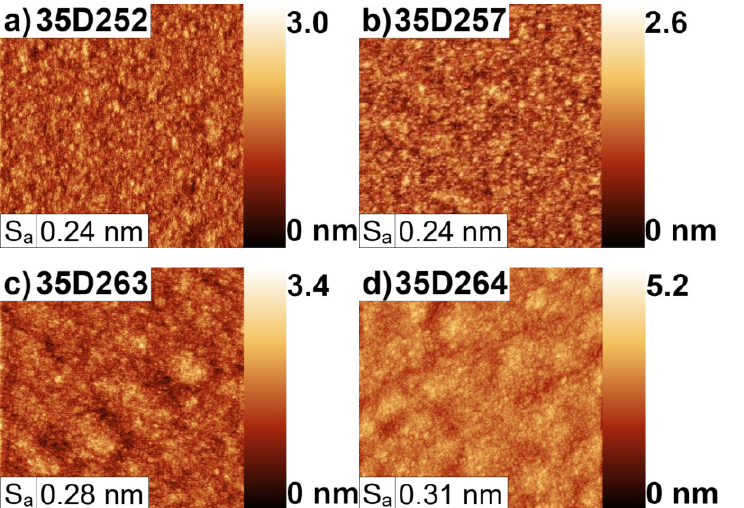
Figure 6. The AFM surface pictures of four InAs/AlSb T2SL samples: ( a ) 35D252, ( b ) 35D257, ( c ) 35D263, ( d )